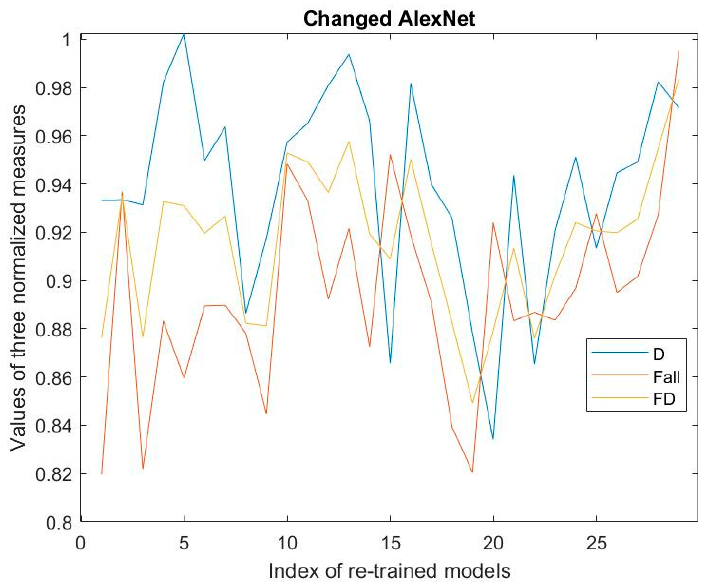
Figure 6. Results regarding changed AlexNet.